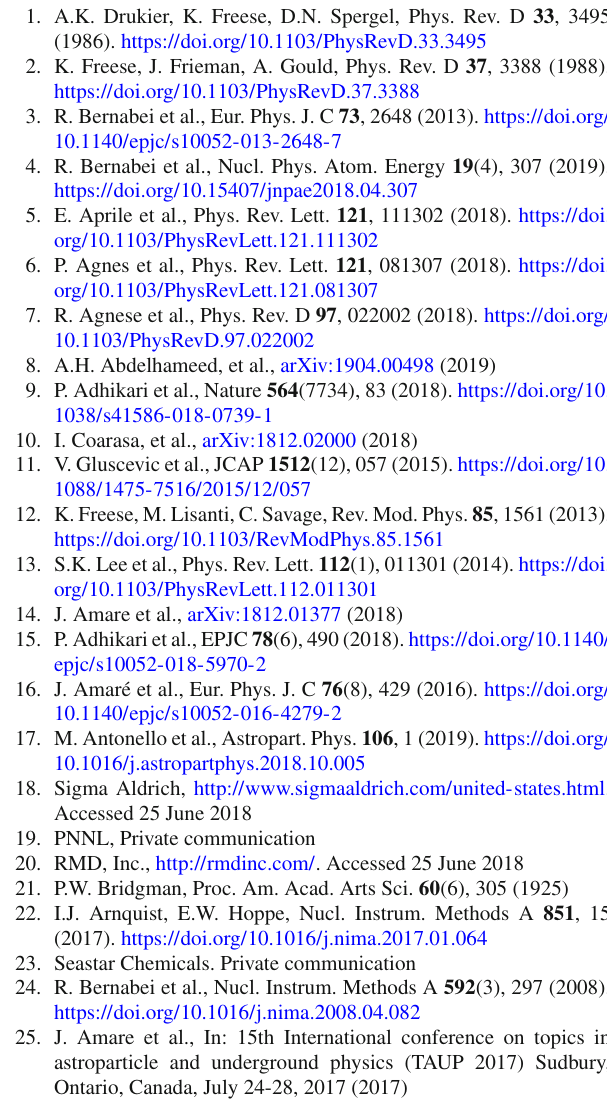
Fig. 4 SABRE sensitivity for a total mass of 50 kg of NaI(Tl) crys- tals over 3 years of data collection, with uncertainty bands that cover different modeling of efficiency and energy resolution. The blue curves represent the 3 and 5 sigma confidence regions we obtained interpret- ing the DAMA Phase-1 results [3,36] in the framework of the standard WIMP model, as described in